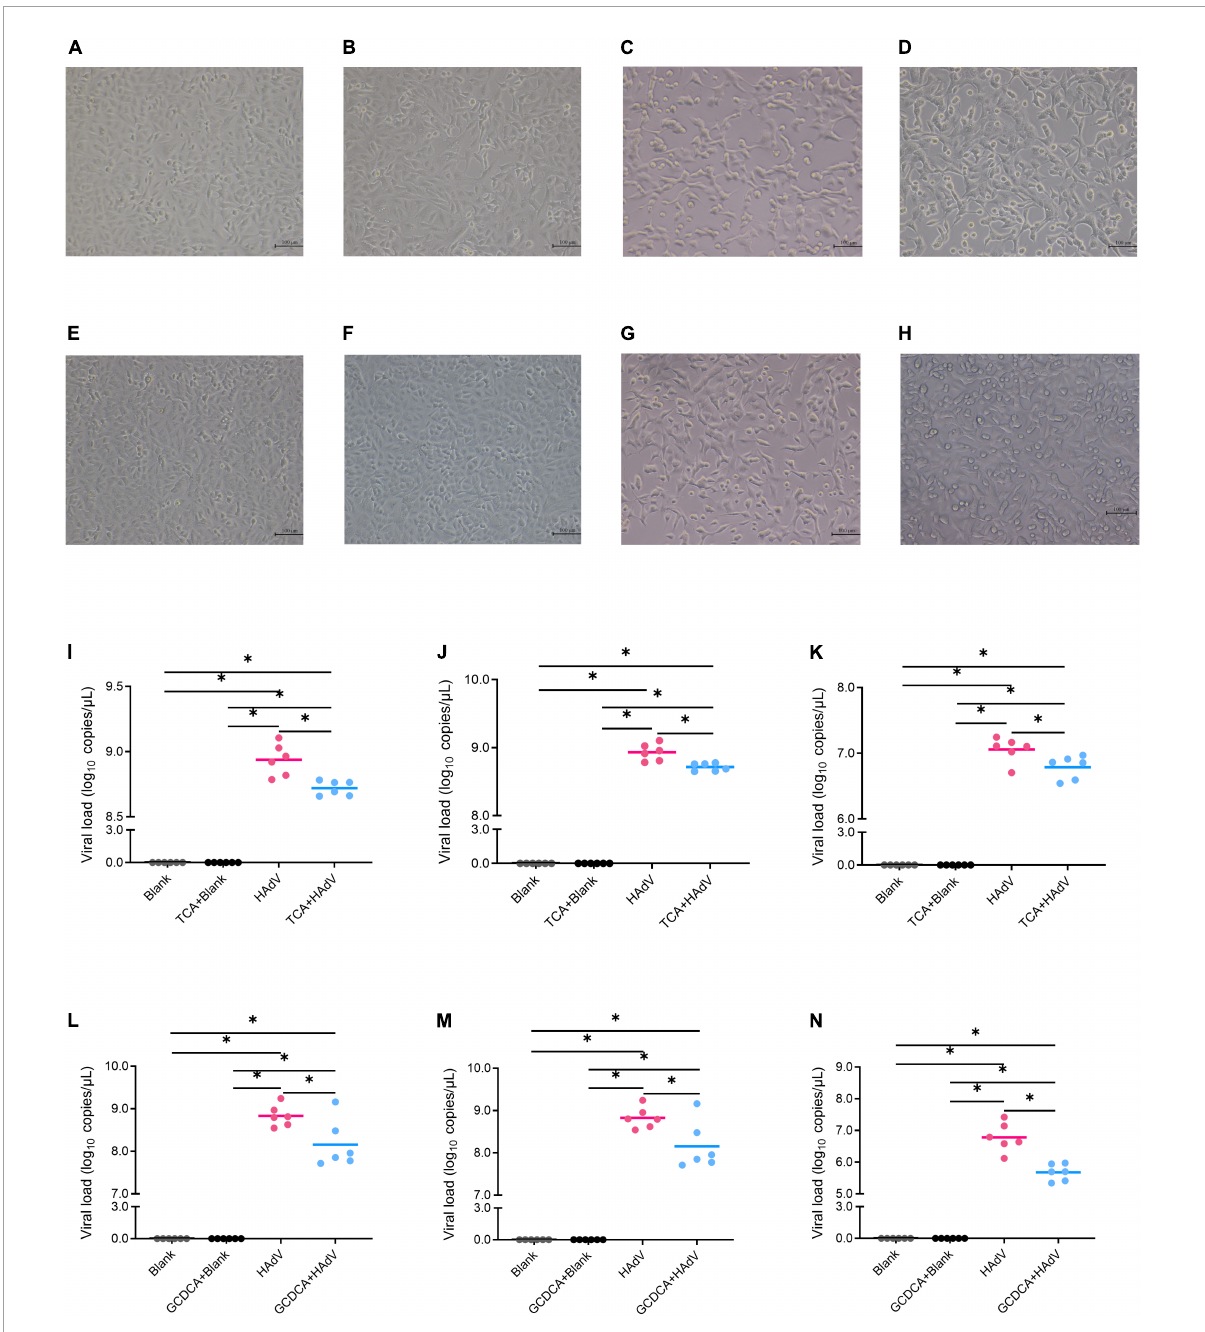
FIGURE5 Effects of bile acids, including TCA and GCDCA, on HAdV-7 replication in the A549 cell line. (A–H) Show the cytopathic effect via microscopy observations; (A) the blank control for TCA test; (B) the blank control with TCA; (C) the HAdV-7-treated cells; (D) the HAdV-7-treated cell with TCA; (E) the blank control for GCDCA test; (F) the blank control with GCDCA; (G) the HAdV-7-treated cells; (H) the HAdV-7-treated cell with GCDCA). (I–N) Show the viral load in the blank control and HAdV-7 infection groups with or without bile acids at a MOI = 1. (I) Total viral loads with TCA; (J) viral loads with TCA in cell lysates; (K) viral loads with TCA in supernatants; (L) total viral loads with GCDCA; (M) viral loads with GCDCA in cell lysates; (N) viral loads with GCDCA in supernatants. All the experiments were repeated for six times ∗ p < 0.05.